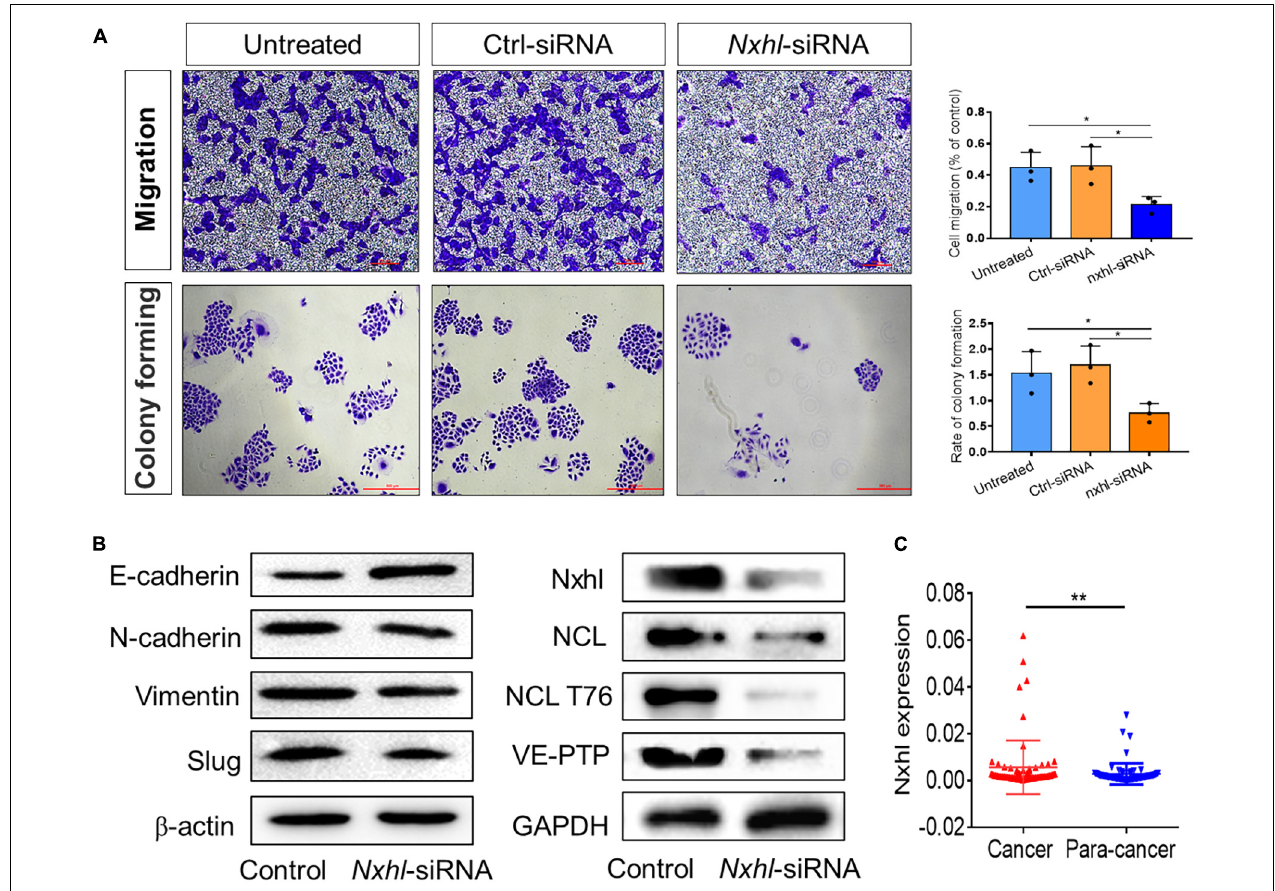
FIGURE 7 | Nxhl attenuates tumor invasion and proteins associated with angiogenesis and EMT. (A) Silence of nxhl (homolog of Harbi1) inhibits migration and EMT of HCC cells. Representative images of migrated cells stained with crystal violet and inhibition of migration in nxhl -siRNA treated HepG2 cell (up row). Representative images of colony formation cells stained with crystal violet and inhibition of colony forming in nxhl -siRNA treated HepG2 cell (down row). (B) Silence of nxhl inhibits epithelial-mesenchymal transition of HepG2 cells. Four EMT marker proteins, NCL, NCL T76 and VE-PTP were detected using Western blotting method in control and siRNA-treated HepG2 cells. (C) nxhl (Harbi1) expression in 72 HCC tissues and para-cancer tissues. qPCR was used to determine the human homolog of nxhl (Harbi1) expression levels. The data above represent as mean ± SEM from three independent experiments. * p < 0.05, ** p < 0.001 represents statistically